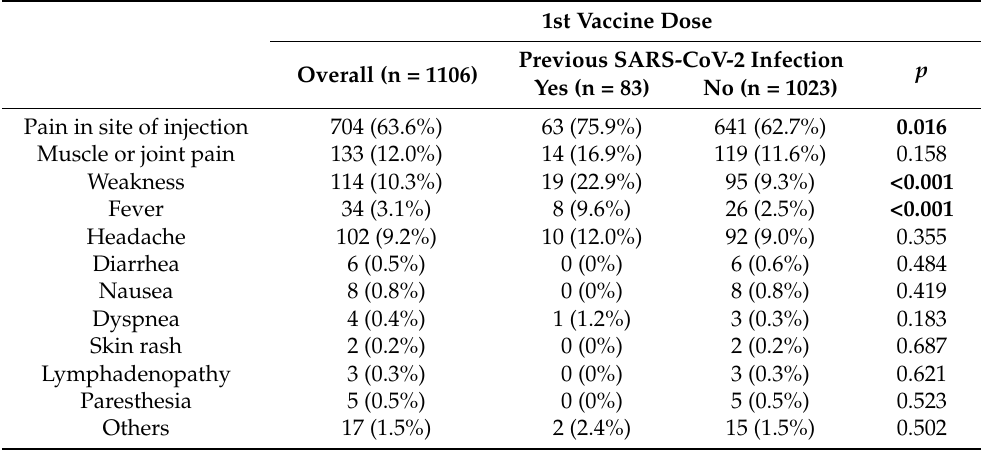
Table 2. Type of side effects in the study population after the first vaccine dose, overall and stratified according to prior SARS-CoV-2